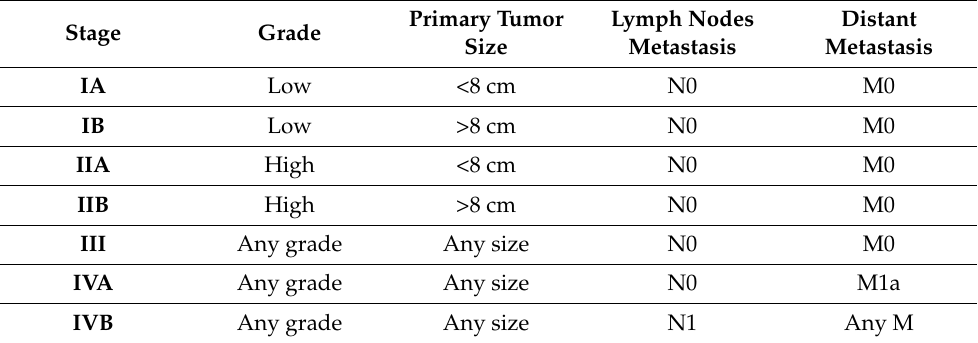
Table 2. AJCC (American Joint Committee on Cancer) staging system for osteosarcoma. Each stage is characterized by a grade (low, high), the primary tumor size and presence of regional lymph nodes (N0 = no regional lymph nodes metastasis; N1 = regional lymph nodes metastasis) and distant metastasis (M0 = no distant metastasis; M1a = lung metastasis; any M = lung and other distant sites). Adapted from Ritter et Bielack